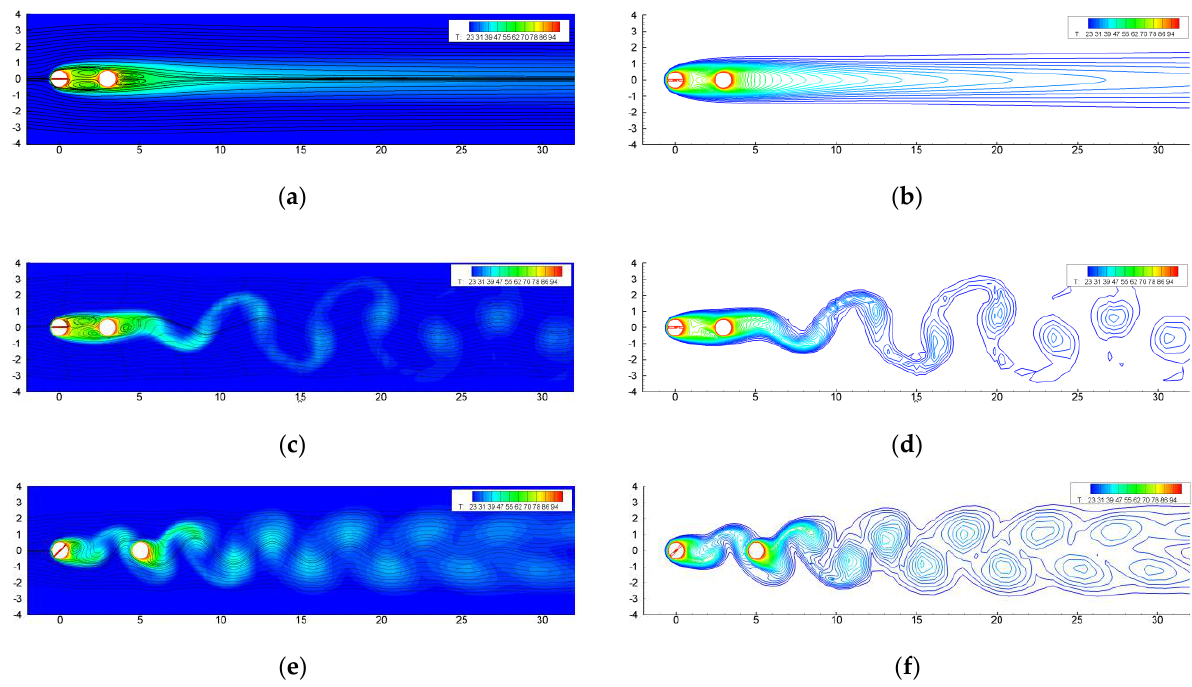
Figure 15. Three major flow patterns of the slotted tandem array: streamline ( left ); temperature contours ( right ). ( a , b ) Stable reattachment, Re = 100, L/D = 3, α = 0° ; ( c , d ) unstable reattachment, Re = 200, L/D = 3, α = 0° ; ( e , f ) co-shedding, Re = 100, L/D = 5, α = 45° .